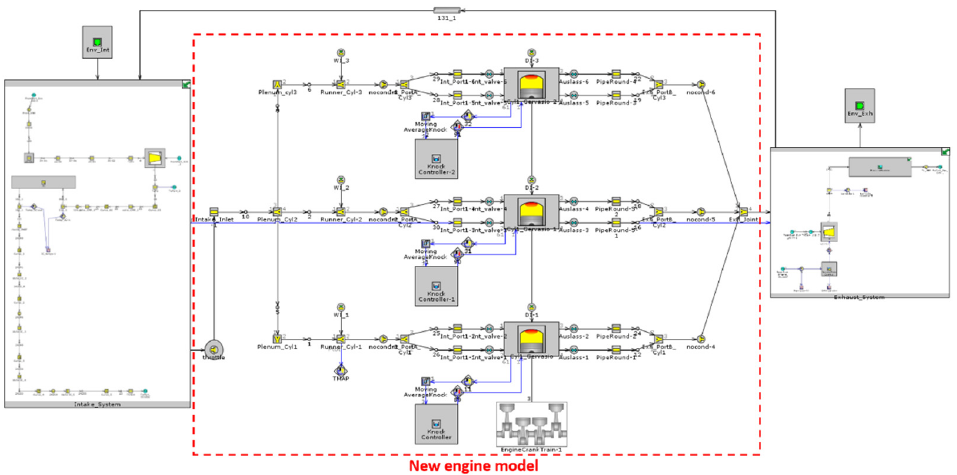
Figure 4. The 3-cylinder ethanol engine numerical simulation model.